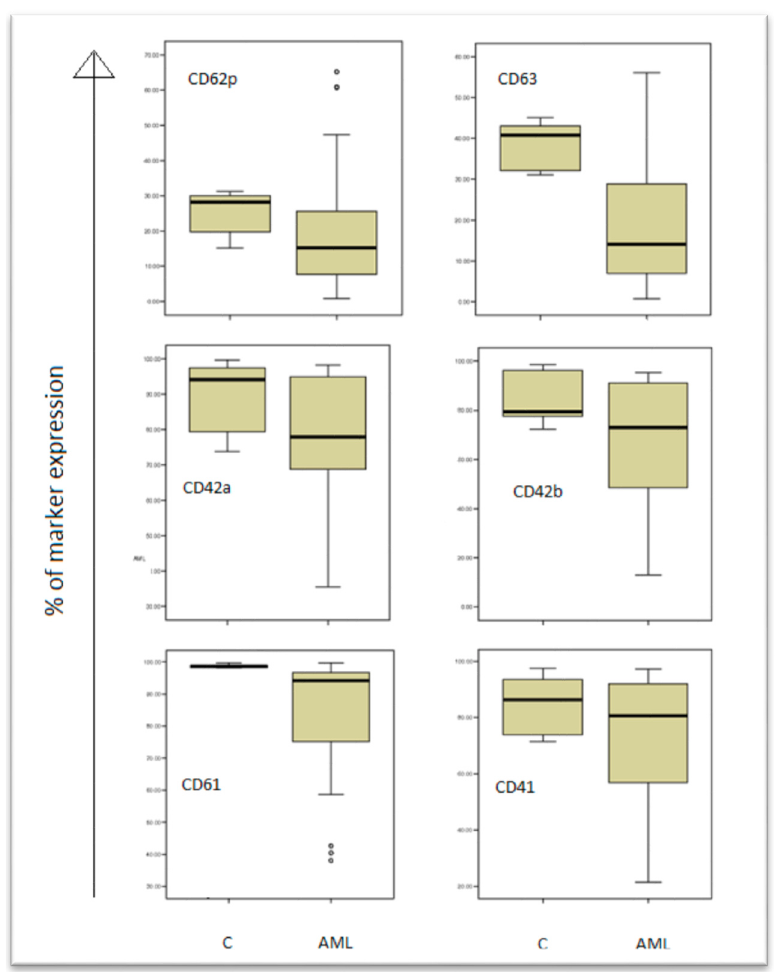
Figure 2. Expression of platelet activation markers in acute myeloid leukaemia (AML) patients and controls (C). controls